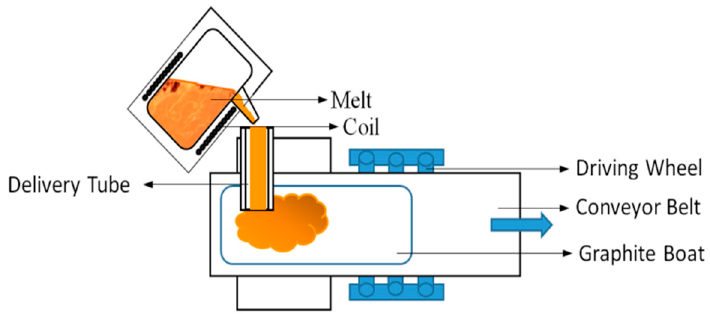
Figure 1. Schematic diagram of FeSi master alloy casting.